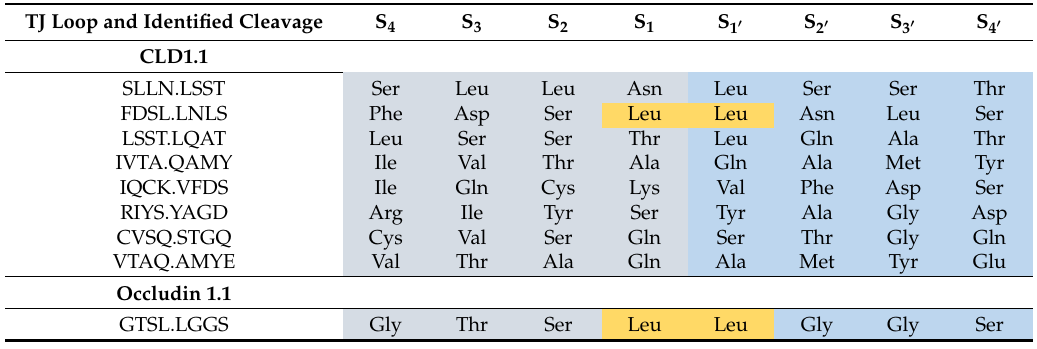
Table 3. Cleavage sites for Der p 1 identified in CLD1.1. Peptides identified by LC-MS-MS were used to identify positional cleavages indicated by single letter amino acid notation in the first column. Implied subsite specificity of Der p 1 is indicated for positions S 4 –S 4 (cid:48) . Similarity with potential cleavage sites in the first extracellular domain of occludin are highlighted in yellow. Grey and blue shading denote non-prime and prime subsite interactions of Der p 1 relative to the cleavage site (Schecter and Berger